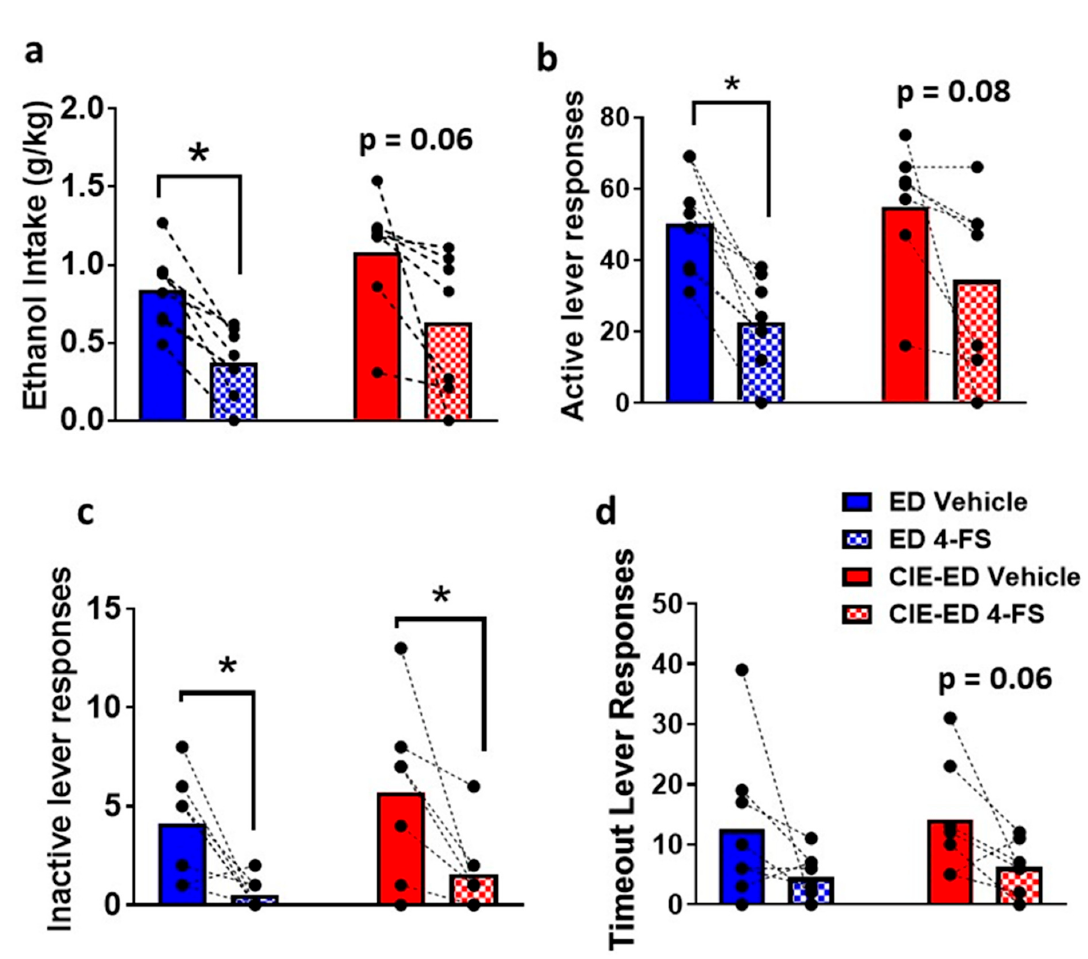
Figure 5. 4 ‐ FS reduces drinking in ethanol drinking (ED) rats. ( a ) Ethanol intake expressed as g/kg and ( b ) active lever responses. ( c ) Inactive lever responses and ( d ) lever responses during timeout. n = 8 4 ‐ FS ED rats, n = 7 4 ‐ FS CIE ‐ ED rats. * p < 0.05 vs. vehicle day, within ‐ subject. Data are expressed as mean ± S.E.M.